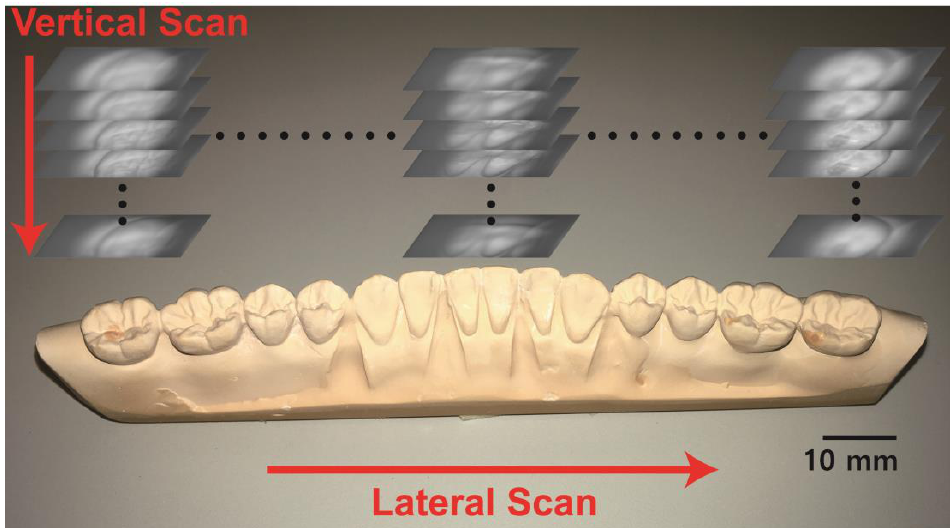
Figure 2. Picture of the dental cast (gypsum model) and the images captured by the scanning apparatus from the top view. Scanning process: Images of the dental cast were recorded with varying objective lens focal length (vertical scan). The dental cast moved laterally after each vertical scan was finished (lateral scan). Scale bar: 10 mm.